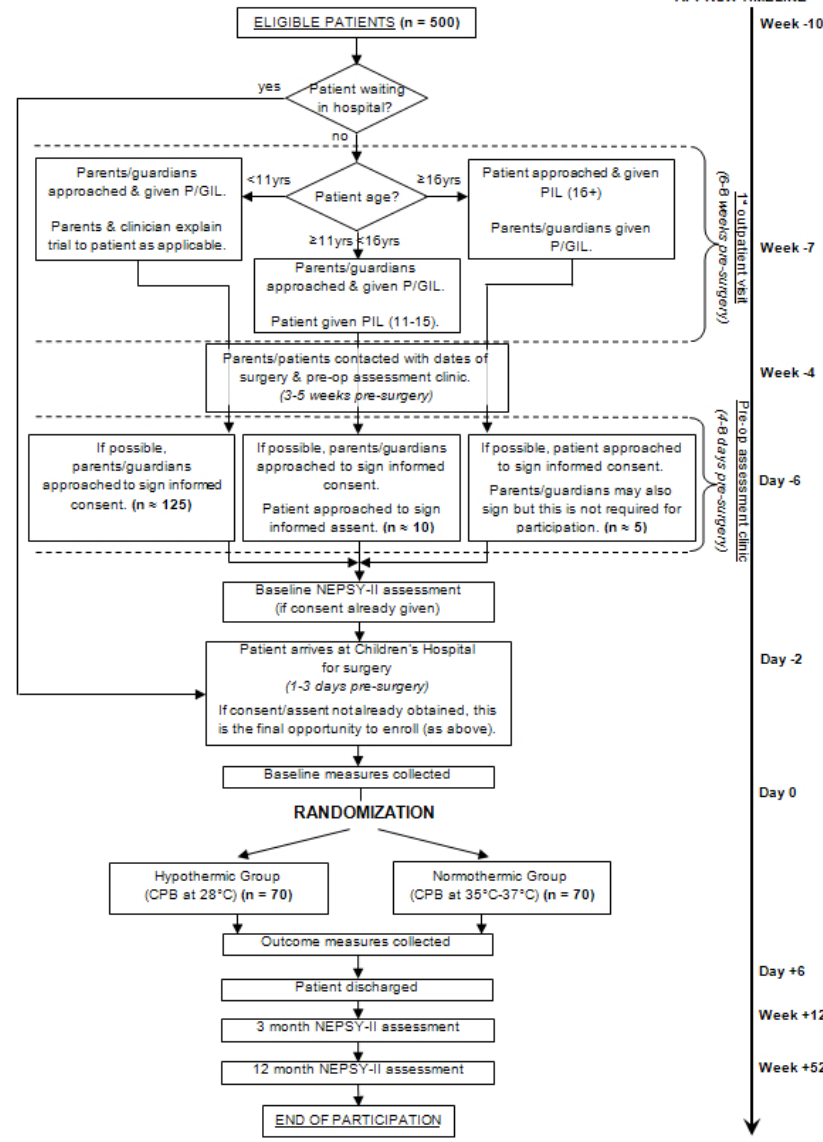
Figure 1. Study schema showing the participant recruitment